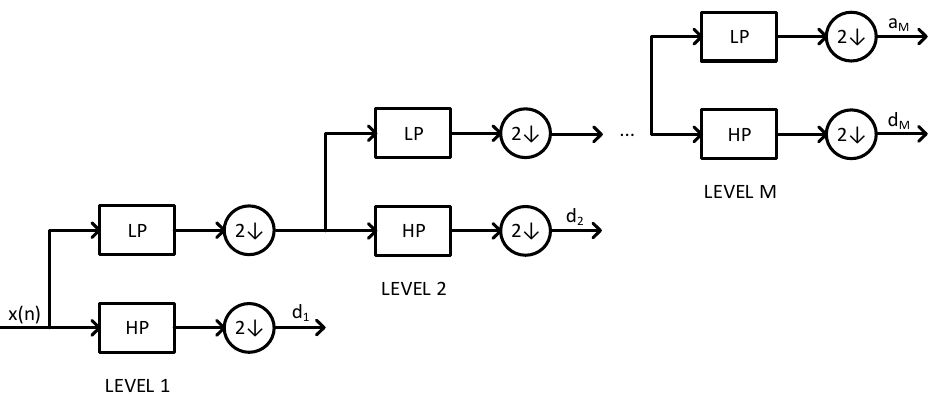
Figure 1. M levels of discrete wavelet transform decomposition. Table 1. Frequency band and number of samples of coefficients for M DWT decomposition levels. Coefficients